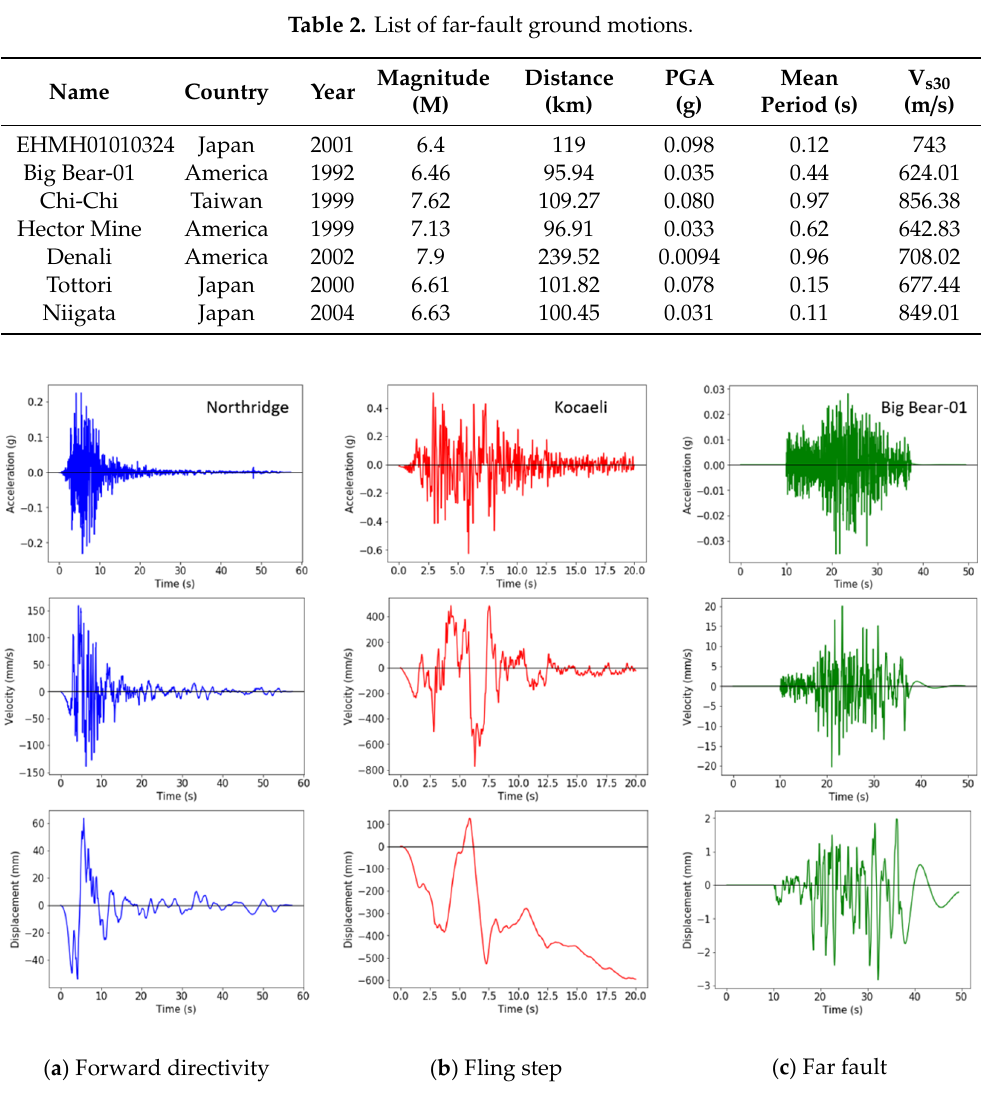
Figure 1. Typical time histories of the near-fault ground motion with forward-directivity and fling-step effects and the far-fault ground motion: ( a ) Near-fault ground motion with forward directivity; ( b ) near-fault ground motion with fling step; ( c ) far-fault ground motion